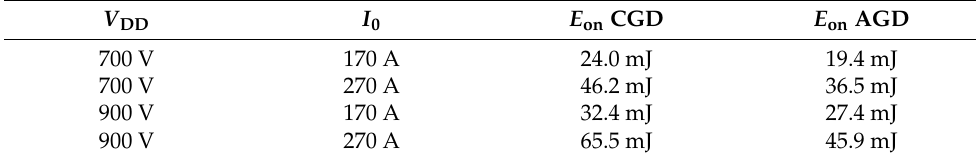
Figure 5. The turn-on cycle of the SiC MOSFET from module CAS300M17BM2 using AGD. V DD = 700 V, I 0 = 270 A. Table 1. The turn-on energy losses of CGD and AGD comparison from the simulation